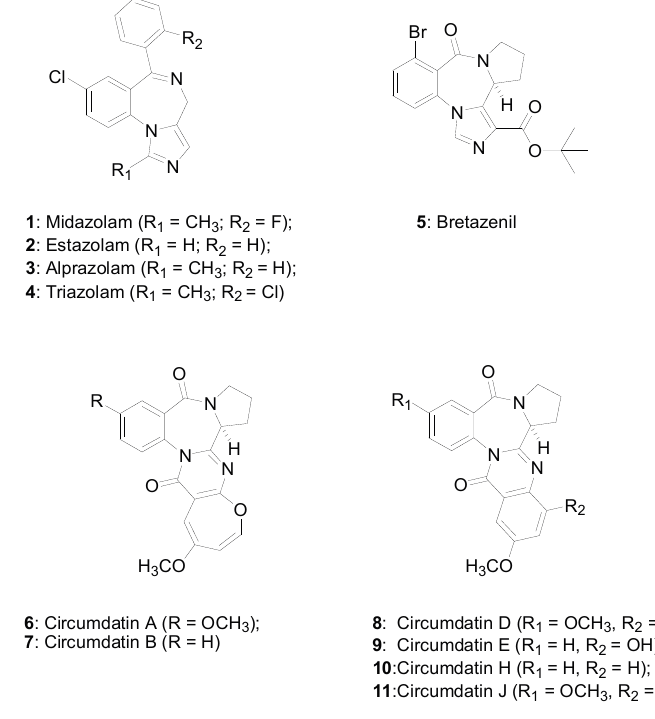
Figure 1. Members of the fused hetero-cyclic benzodiazepine